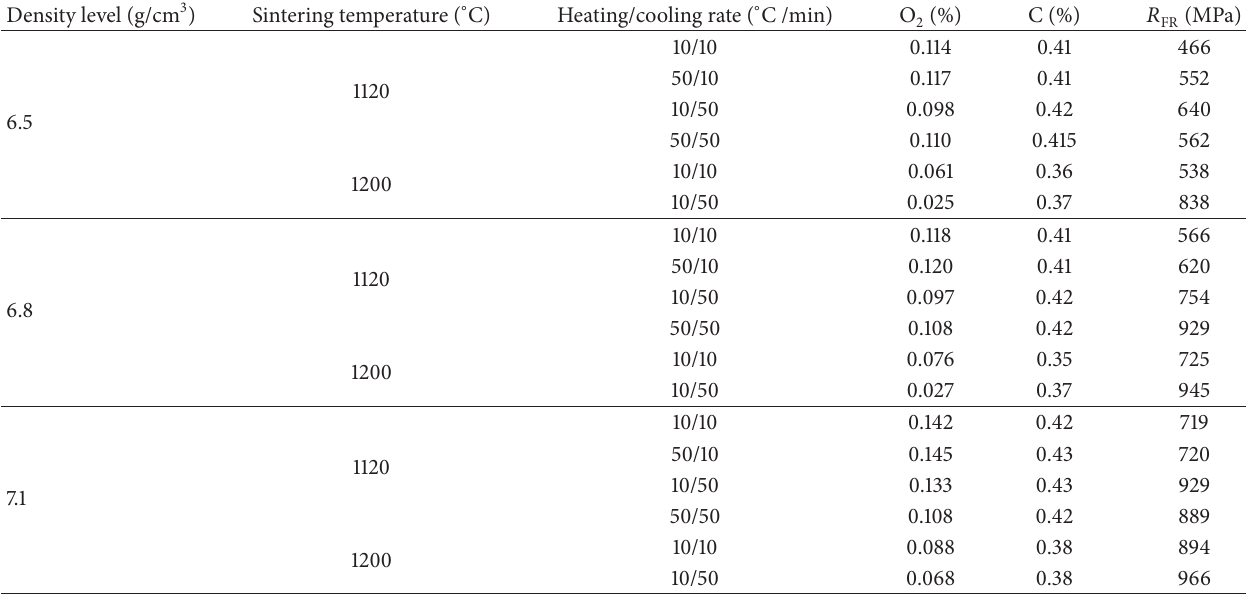
Table 5: Effect of heating and cooling rates on oxygen and carbon contents and fracture strength of AstCrM + 0.5% C material sintered at 1120 and 1200 ∘ C in relation to density.